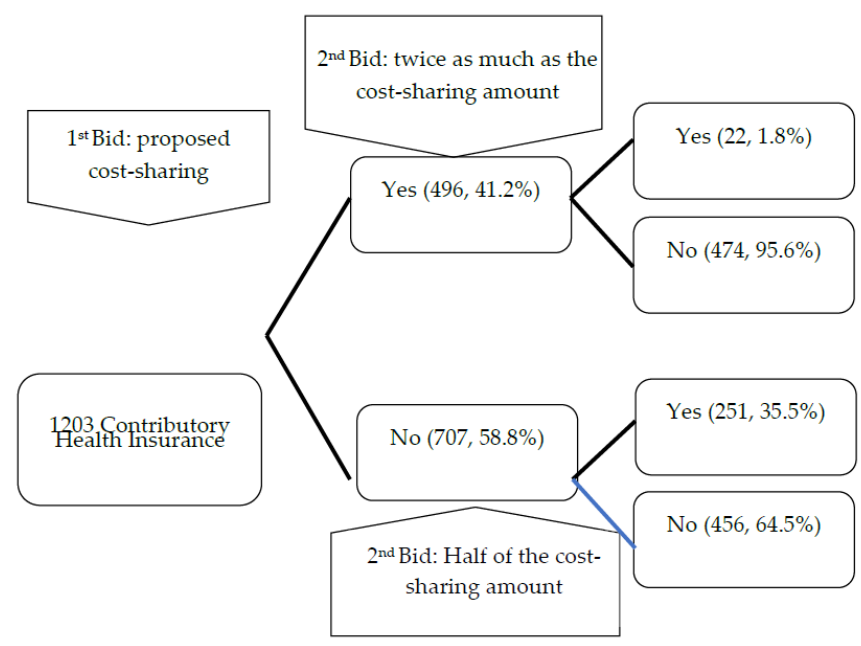
Figure 1. Willingness to pay for cost-sharing under the National Health Insurance scheme.